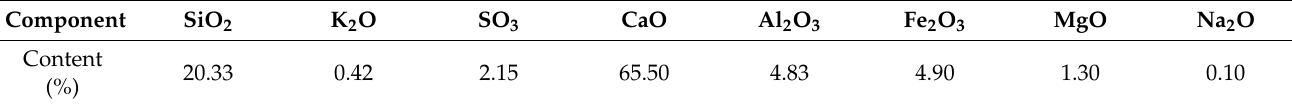
Table 3. Contents of main compounds in cement.